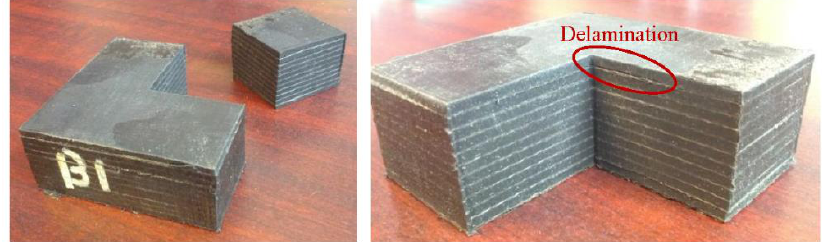
Figure 15. Detached carbon fiber-reinforced elastomeric pad (B1) after conducting shear and compression tests.